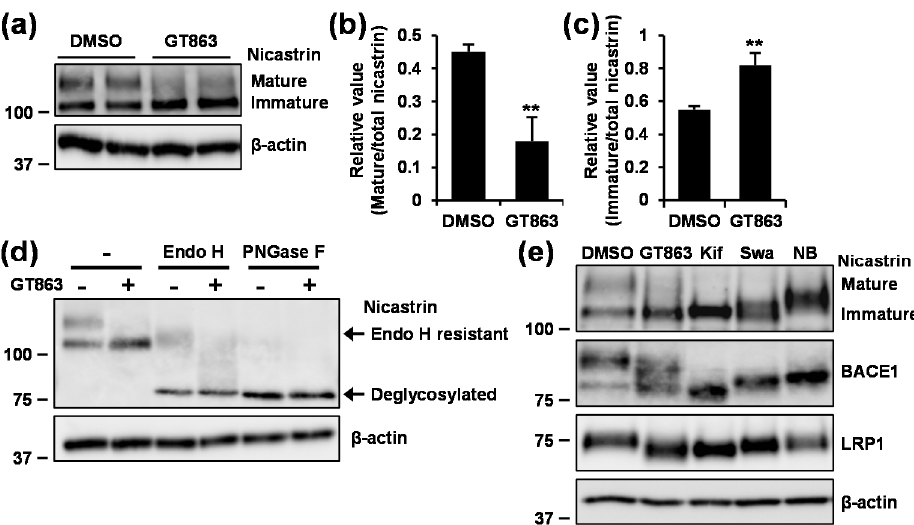
Figure 5. Effect of GT863 on nicastrin maturation. ( a–d ) CHO-APP/Notch Δ E cells were treated with 3 μ M GT863 for 48 h. ( a ) Whole cell lysates were immunoblotted with appropriate antibodies specific for nicastrin or β -actin. ( b,c ) Band intensities of mature ( b ) and immature ( c ) nicastrin were quantified by densitometric scanning, with the relative value being shown. Mean ± SD n = 3, ** p < 0.01, n.s. = not significant. ( d ) Whole cell lysates were untreated or treated with endoglycosidase H (Endo H) or peptide-N-glycosidase F (PNGase F), and immunoblotted with appropriate antibodies specific for nicastrin or β -actin. ( e ) CHO-APP/Notch Δ E cells were treated with 3 μ M GT863, 1 μ g/mL kifunensine (Kif), 1 μ g/mL swainsonine (Swa), or 1 mM N -butyl-deoxynojirimycin (NB-DNJ) (NB) for 48 h. Whole cell lysates were immunoblotted with appropriate antibodies as indicated. LRP1: low-density lipoprotein (LDL) receptor-related protein 1; BACE1: β -site APP cleaving enzyme 1.